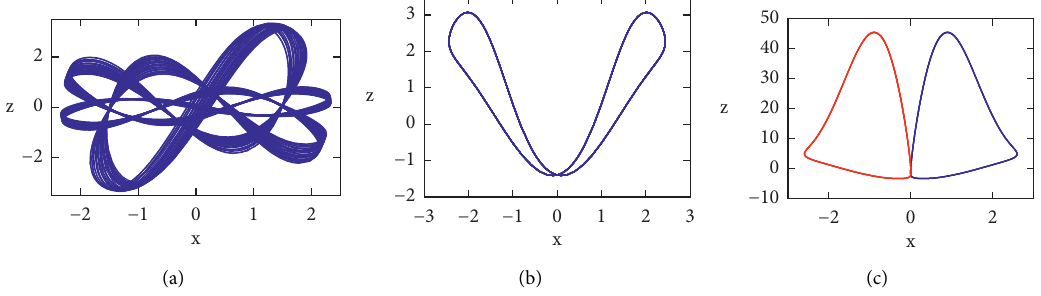
Figure 1: Attractors of system (1) in b � − 1 ,c � 1 , and e � 0 and various values of a : (a) a �− 6.17; (b) a � − 4.5; (c) a �− 0.8. Table 1: Attractors of system (1) for different values of parameters a and b � − 1 , c � 1 , and e � 0. Parameter